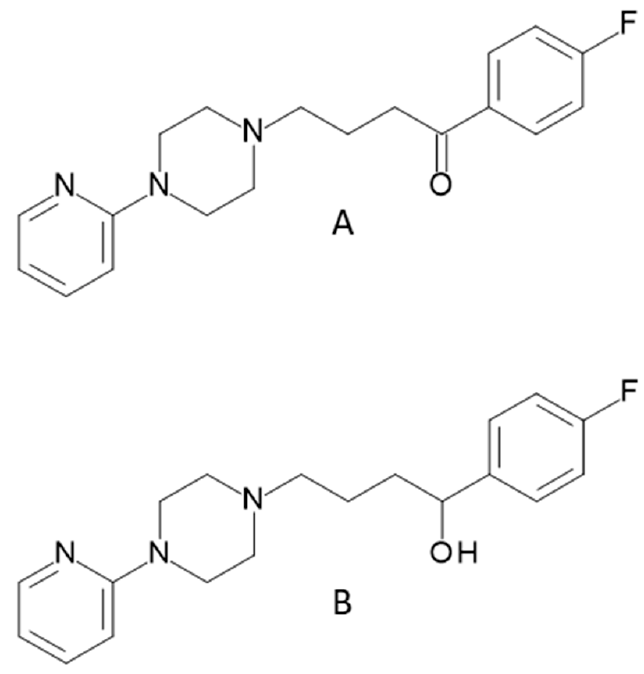
Figure 1. Structure of azaperone ( A ) and azaperol ( B